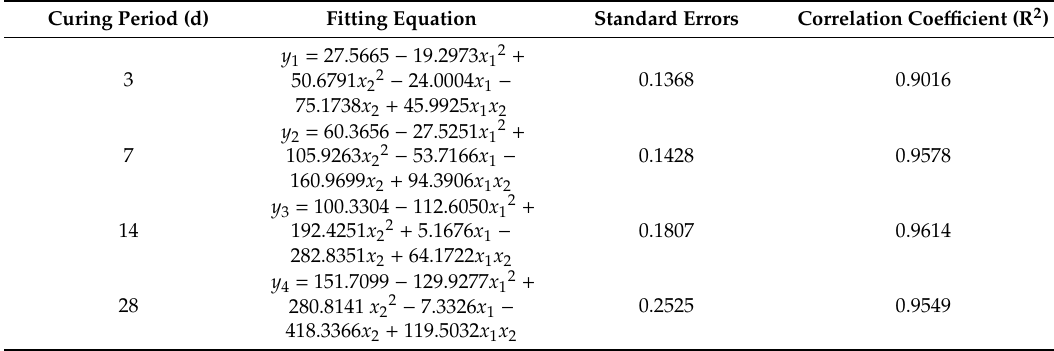
Table 7. Results of fitting analysis.